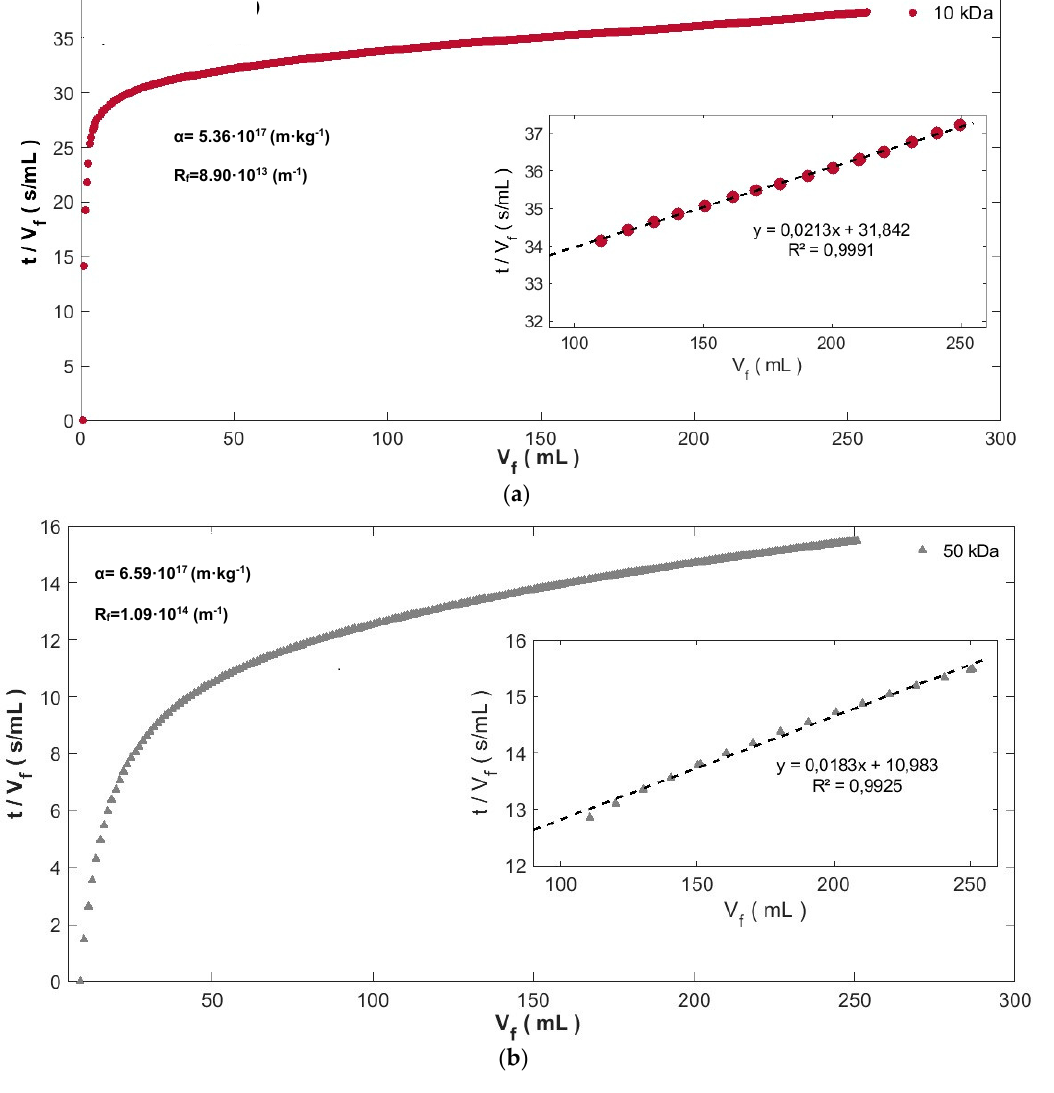
( c ) Figure 4. Specific resistance ( α ) and fouling resistance ( 𝑅 (cid:3033) ) calculated using the resistance-in series- model for ( a ) 10 kDa molecular weight cut-off (MWCO), ( b ) 50 kDa MWCO, and ( c ) 100 kDa MWCO membranes. The highest values for 𝑅 (cid:3033) were obtained at the highest mass of DCS ( 𝑚 (cid:3005)(cid:3004)(cid:3020) ) deposited on the membrane area per unit of permeate volume due to a more compact cake structure on the membrane surface. Thus, the 𝑅 (cid:3033) for the 10 kDa MWCO membrane, was around 8.90 × 10 (cid:2869)(cid:2871) m (cid:2879)(cid:2869) , for the 50 kDa MWCO, it was 1.09 × 10 (cid:2869)(cid:2872) m (cid:2879)(cid:2869) , and for the 100 kDa MWCO, it was 1.77 × 10 (cid:2869)(cid:2872) m (cid:2879)(cid:2869) . It is worth mentioning that the nonlinearity of the curves t/ V (cid:2916) vs. V (cid:2916) during the early stages of experiments implies that pore-blocking preceded the cake resistance in the early stage of filtration. Therefore, pore-blocking mechanisms were identified with a method based on a simple parameter estimation in nonlinear regression models (Table 2). Table 5 presented the values of optimized parameters 𝐾 (cid:3004)(cid:3029) , 𝐾 (cid:3036)(cid:3029) , 𝐾 (cid:3046)(cid:3029) , and 𝐾 (cid:3030)(cid:3039) according to Equations (6)–(9), respectively, the comparison of experimental average permeate flux and the predicted average flux, and the corresponding correlation coefficients (R 2 ).